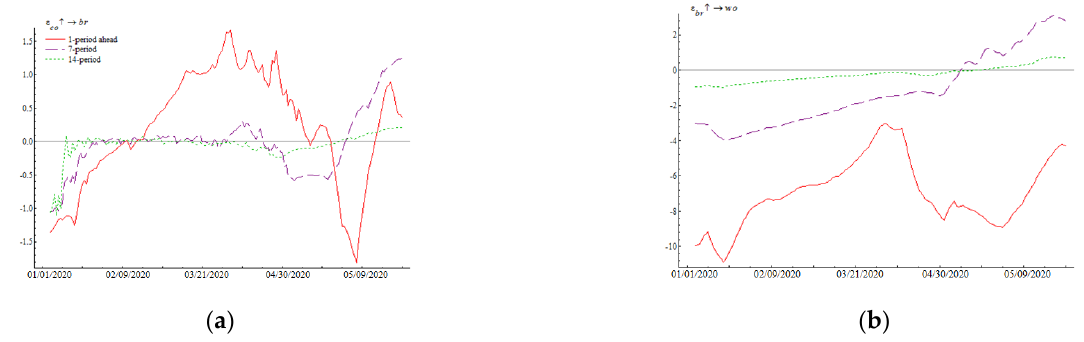
Figure 2. Impulse responses for the set COVID-19, international oil prices, and log prices. Note: The abscissa refers to the date in the first half of 2020, and the ordinate indicates the impulse response values after the shock of one-unit standard deviation. The figure shows the impulse response of oil prices to the pandemic ( a ) and the impulse response of log prices to oil prices ( b ).